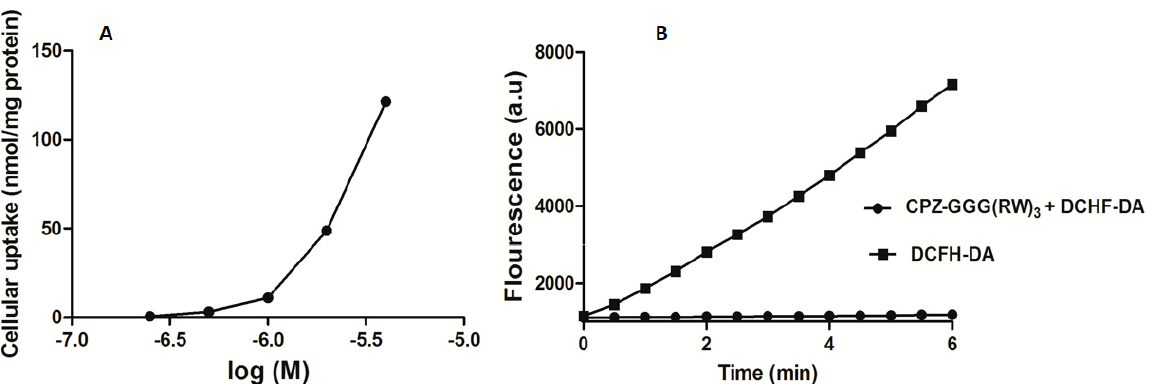
Figure 3. Binding of CPZ-GGG(RW)3 to S. aureus ( A ) and analysis of the ROS generated by CPZG- GG(RW)3 in the presence of probe DCFH-DA (40 µ m, ex 480 nm, em. 528 nm), which is converted into highly fluorescent product (DCF) ( B ).